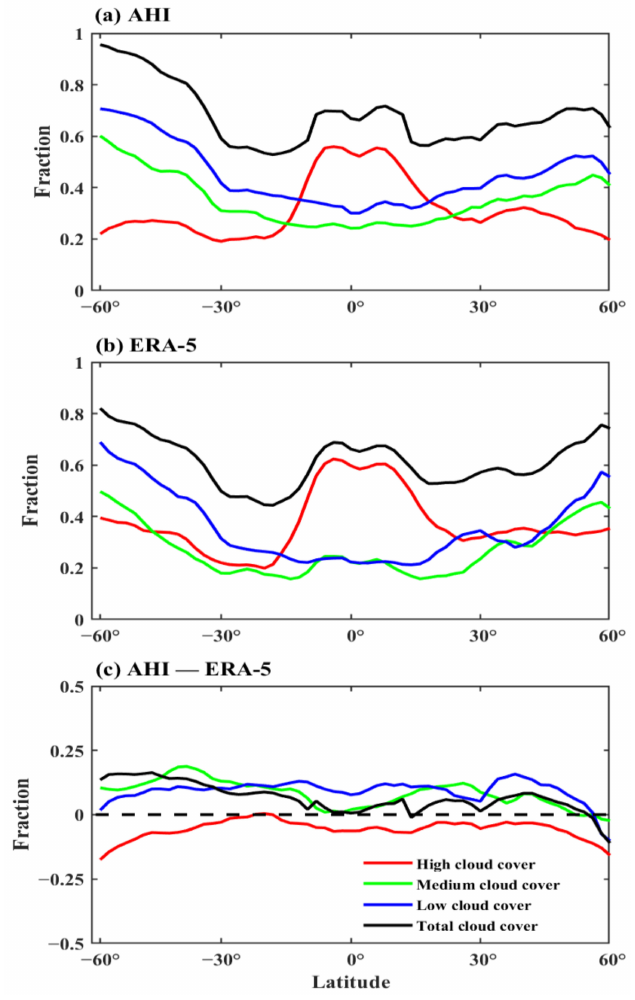
Figure 11. Zonal average total cloud cover (TCC) and layered cloud cover (LCC) from ( a ) the Advanced Himawari Imager (AHI) measurements, ( b ) ERA-5 reanalysis, and ( c ) their